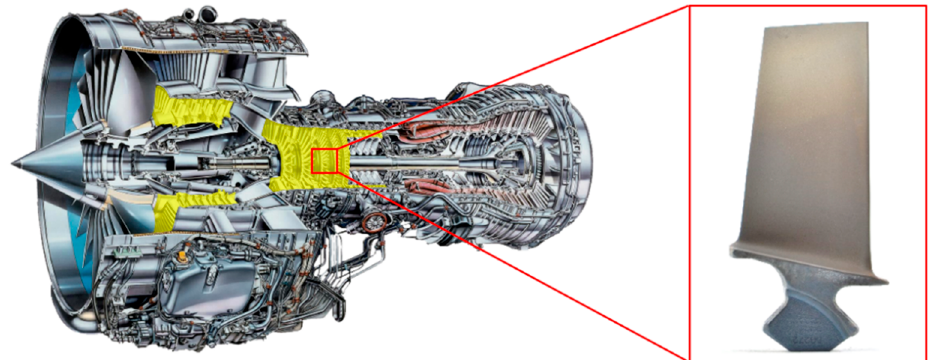
Figure 2. Cross section of a V2500 gas turbine engine with highlighted compressor blades in yellow and exposed sample. Image adapted from [12].